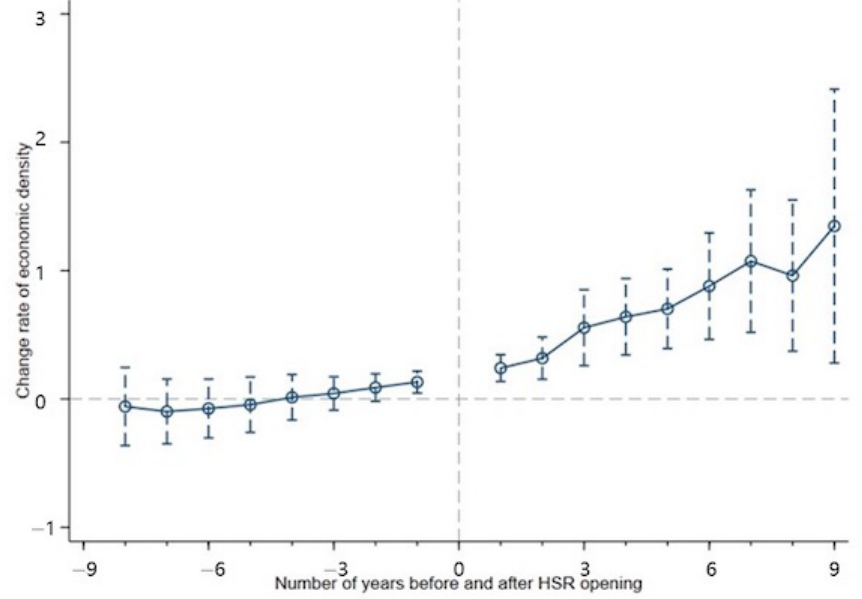
Figure 4. Dynamic impact of HSR on economic